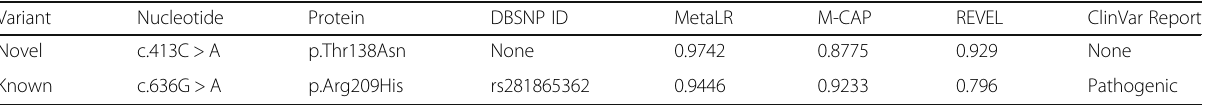
Table 1 A direct comparison of the novel mutation, p.Thr138Asn, and a known pathogenic variant in RS1 . Both variants were analysed with the same bioinformatic pipeline and have been scored by the same computational tools